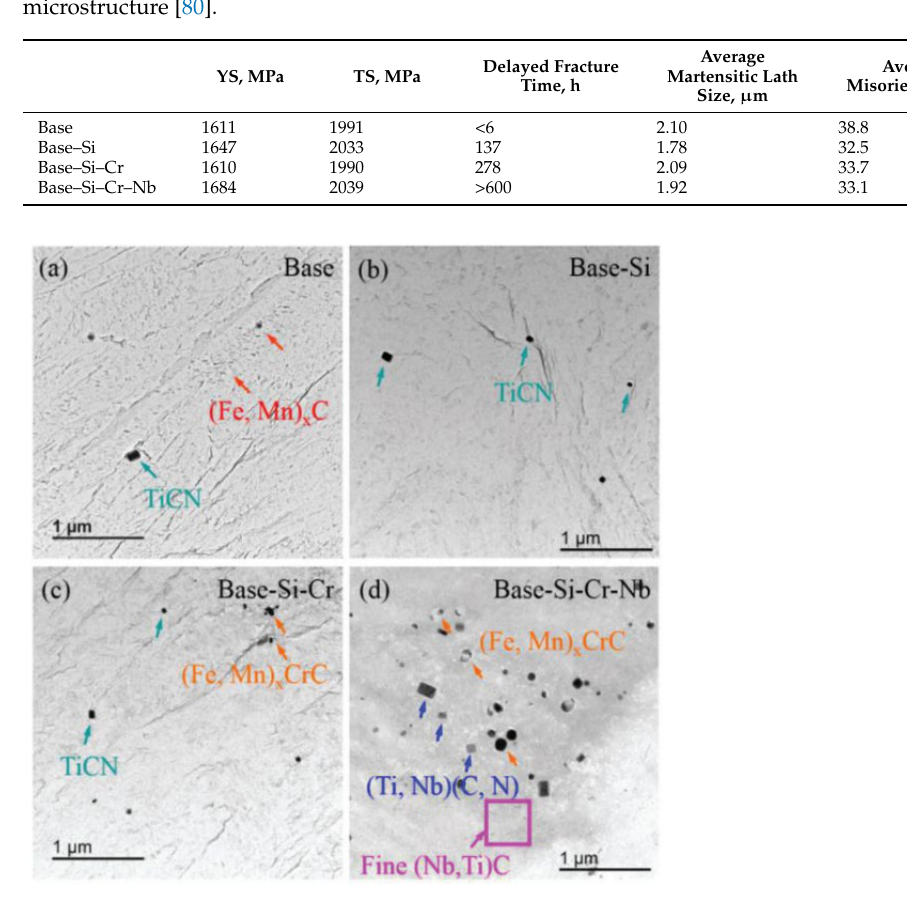
Figure 10. TEM characterization of martensite UHSS carbides with different compositions [80]. ( a ) Base. ( b ) Base–Si. ( c ) Base–Si–Cr. ( d ) Base–Si–Cr–Nb. Reprinted with permission from [80]. Copyright 2022 Springer.